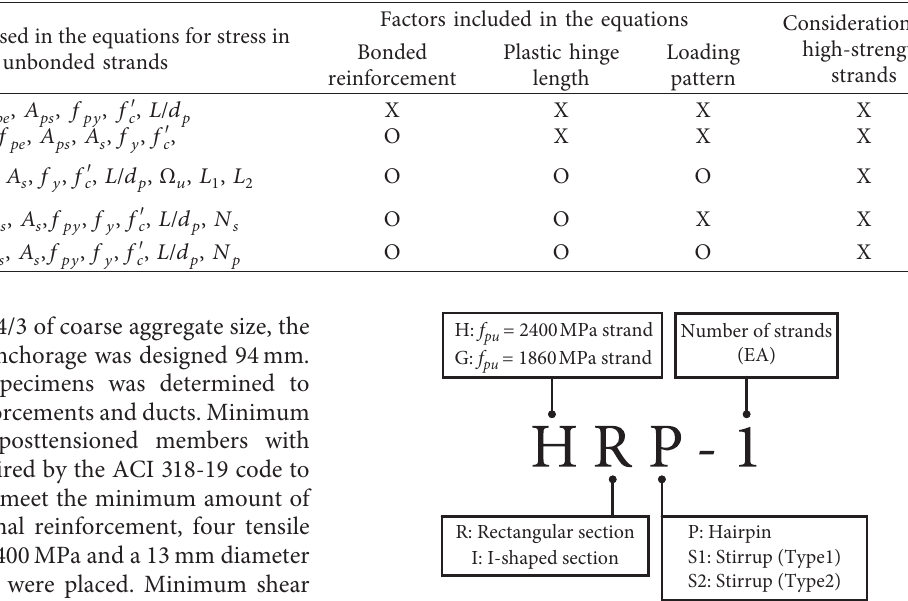
Figure 2: Notation used for